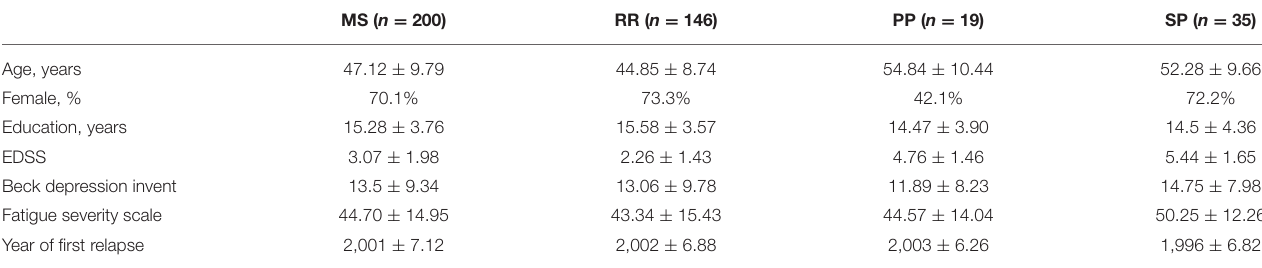
TABLE 1 | Demographic and clinical